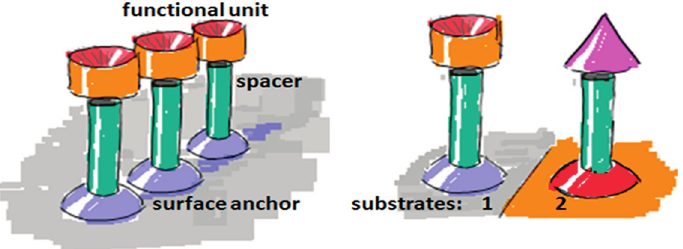
Figure 4. Schematic illustration of the different molecular components required to create a biosensor surface. The surface anchor ensures the binding to the underlying substrate material, the spacer’s role is to screen all interactions of the target with the substrate, and the optional functional unit (recognition element) is used to selectively capture the target. ( Left ): A surface modification scheme on a single substrate material, representative for macro-scale biosensors; ( Right ): A biosensor surface consisting of two different